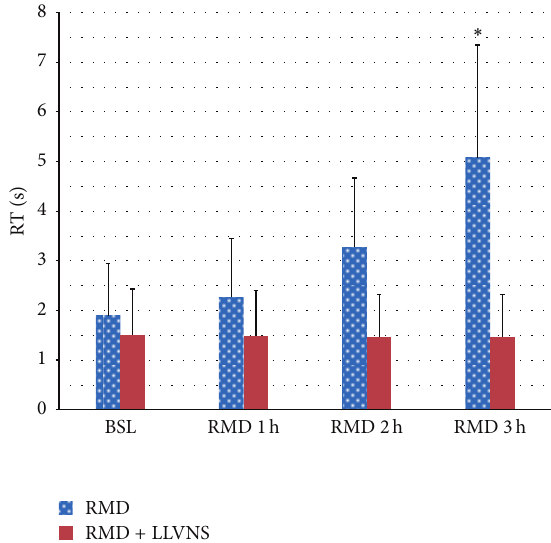
the WOV progressively increased across sites in the given order: RAA and RA, LAA, LA, MSL, RIPV, LIPV, LSPV, ARGPM, and RSPV.